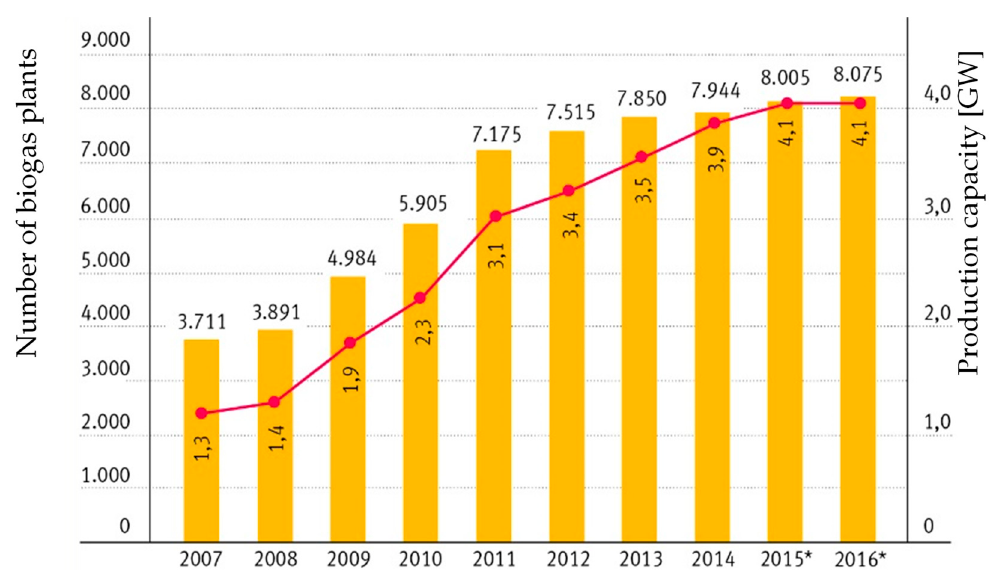
Figure 4. Number of plants (left axis) and corresponding production capacity in Gigawatts (GW) (right axis) of biogas plants in Germany, from 2007 to 2016 [108].